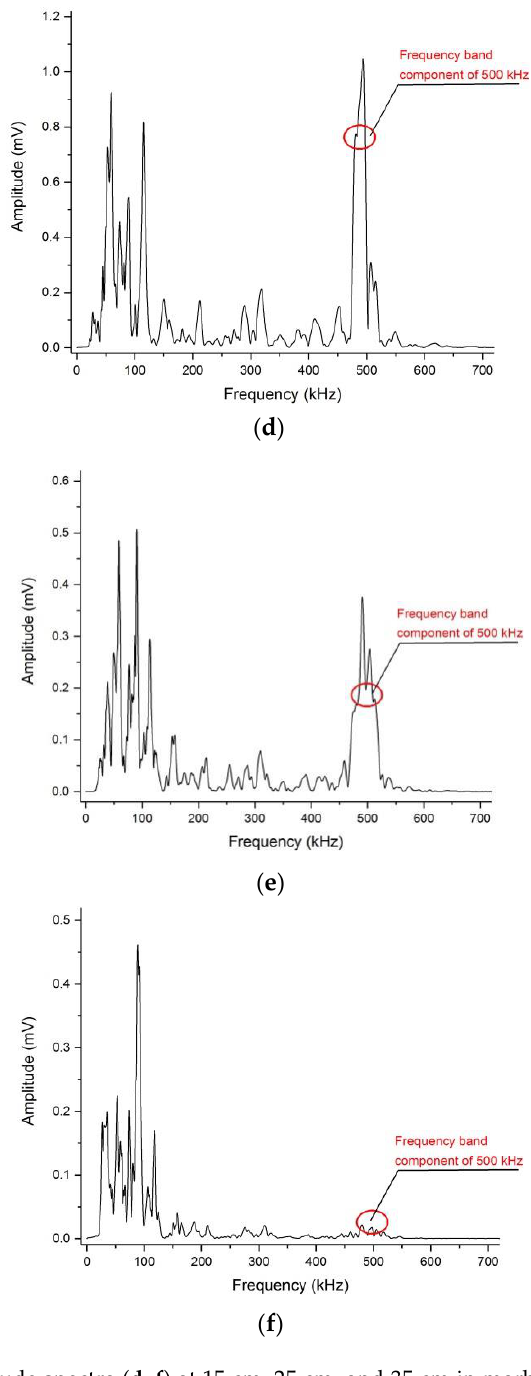
Figure 7. Waveforms ( a – c ) and amplitude spectra ( d – f ) at 15 cm, 25 cm, and 35 cm in marble at a frequency of 500 kHz. The red circles represent the 500 kHz components. Table 6. Fitting relationship between α s and f of the frequency components in waves. Marble